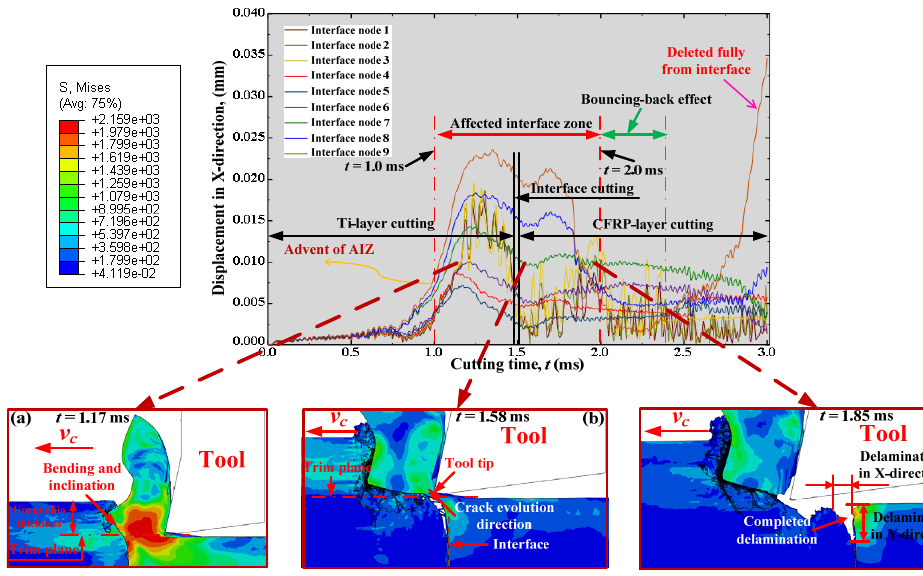
Figure 11. Displacement in X -direction of selected interface nodes versus cutting time ( t ): ( a ) cutting process at t = 1.17 ms; ( b ) cutting process at t = 1.58 ms and ( c ) cutting process at t = 1.85 ms.